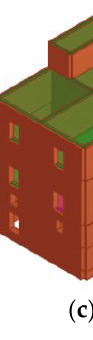
Figure 9. A numerical model of the isolated S.U. located in the intermediate ( a,b ) and head ( c,d ) positions.